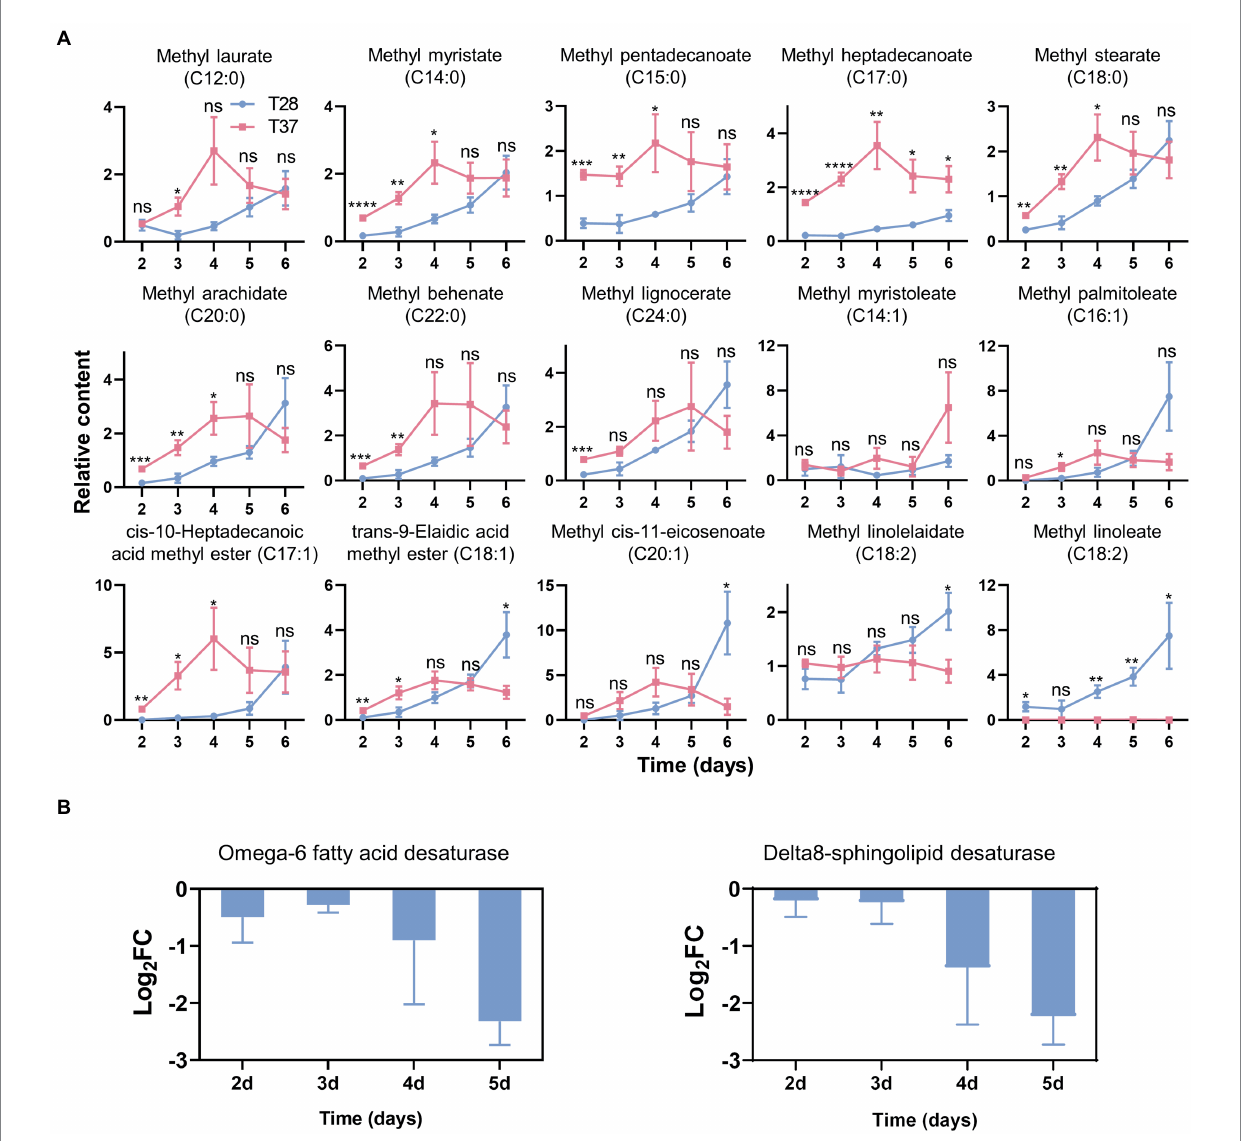
FIGURE 5 Effects of temperature on the contents of fatty acids and the fatty acid metabolism-related genes expression. (A) The relative contents of fatty acids quantified by GC–MS. Significance was determined by the t-test. * p < 0.05, ** p < 0.01, *** p < 0.001, **** p < 0.0001. (B) the Log 2 FC of gene expression levels of fatty acid desaturases as measured via